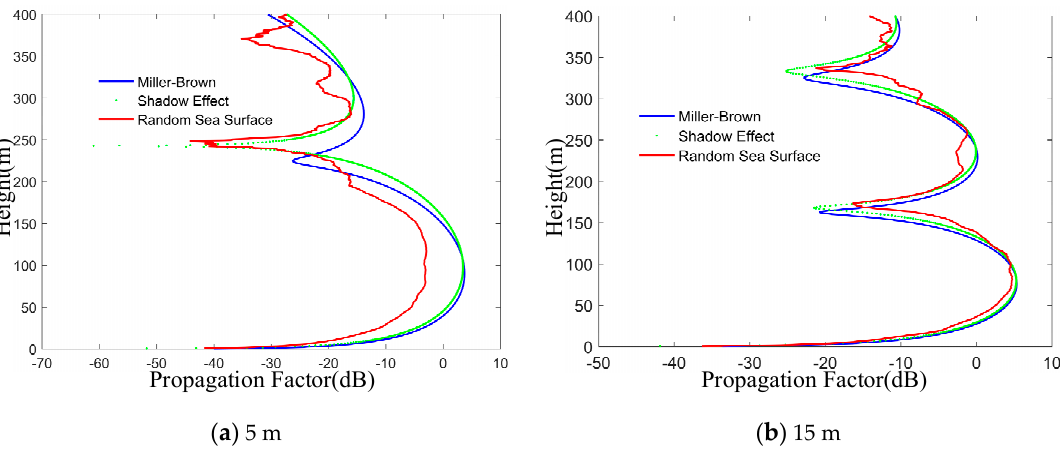
Figure 16. The effects of antenna height on three methods. The two examples; the antenna height ( a ) 5 m and ( b ) 15 m, show comparison of the propagation factors on random sea surface model, Miller-Brown model and shadow effect at different altitudes of the transmitting antenna.